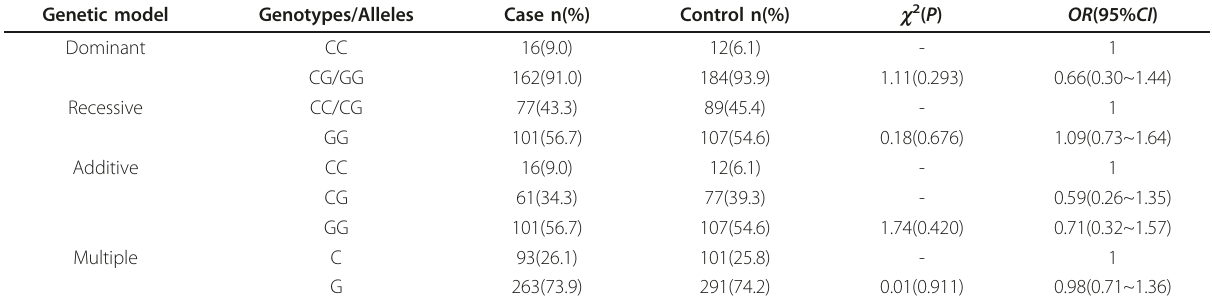
Table 3 Frequency of rs8073069 genotypes/alleles under different genetic models Genetic model